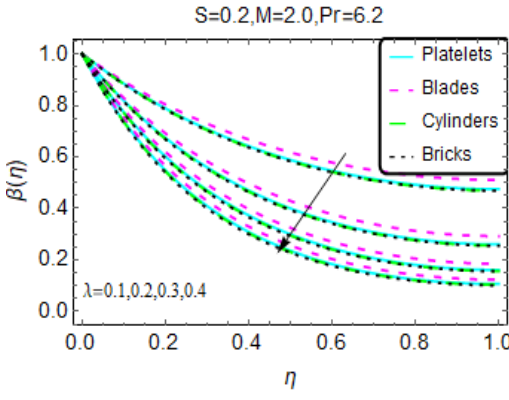
ff erent values of λ Figure 6. The temperature pattern for different values of λ. Figure 6. The temperature pattern for di Figure 6. The temperature pattern for different values of λ.